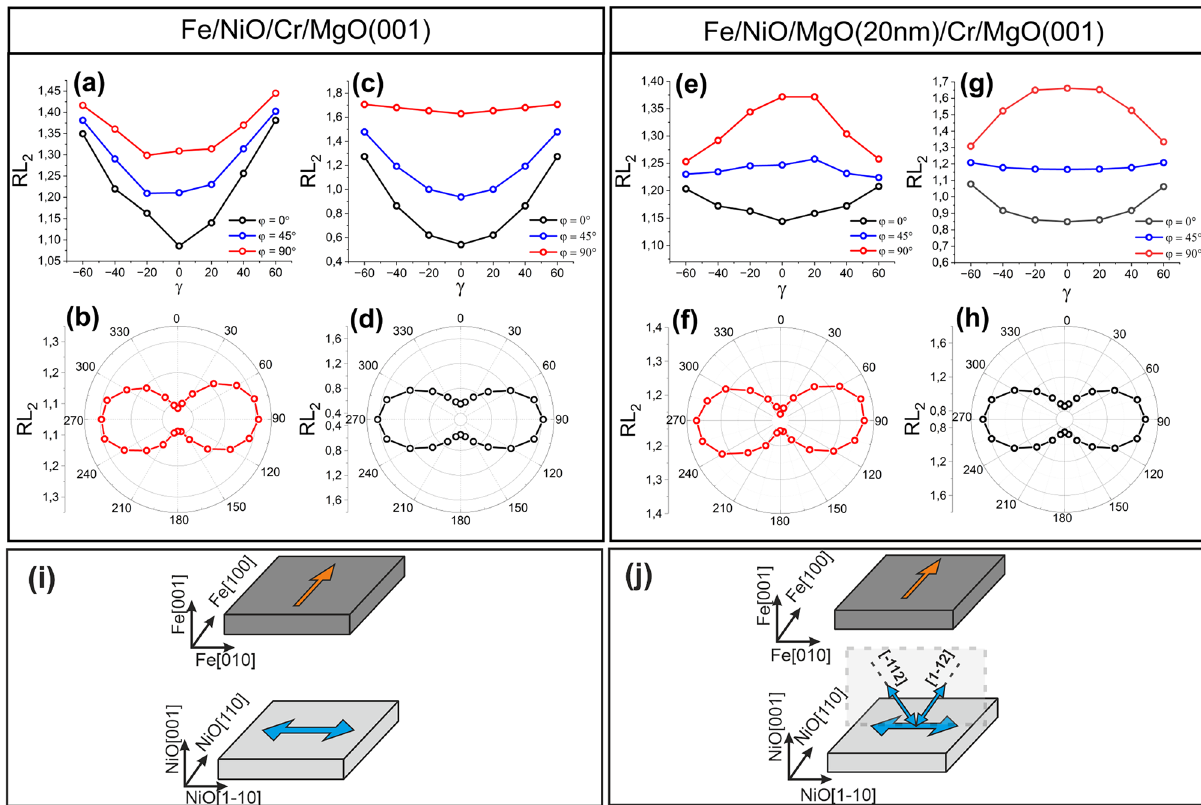
Figure 3. ( a ) and ( b ) Experimental Ni 2+ RL 2 (γ) and RL 2 (φ) dependencies determined for Fe/NiO/Cr/MgO(001) system. ( c ) and ( d ) Calculated RL 2 (γ) and RL 2 (φ) dependencies for NiO spins aligned along NiO[1-10] axis. ( e ) and ( f ) Experimental Ni 2+ RL 2 (γ) and RL 2 (φ) dependencies obtained for Fe/NiO/MgO(200 Å)/Cr/MgO(001) system. ( g ) and ( h ) Calculated RL 2 (γ) and RL 2 (φ) dependencies obtained for an equal population of selected in-plane and out-of-plane NiO domains (see the text for description). ( i ) and ( j ) A schematical illustration of NiO spin structure with directions of magnetic moments indicated by the arrows for Fe/NiO/Cr/MgO(001) and Fe/NiO/MgO(200 Å)/Cr/MgO(001),